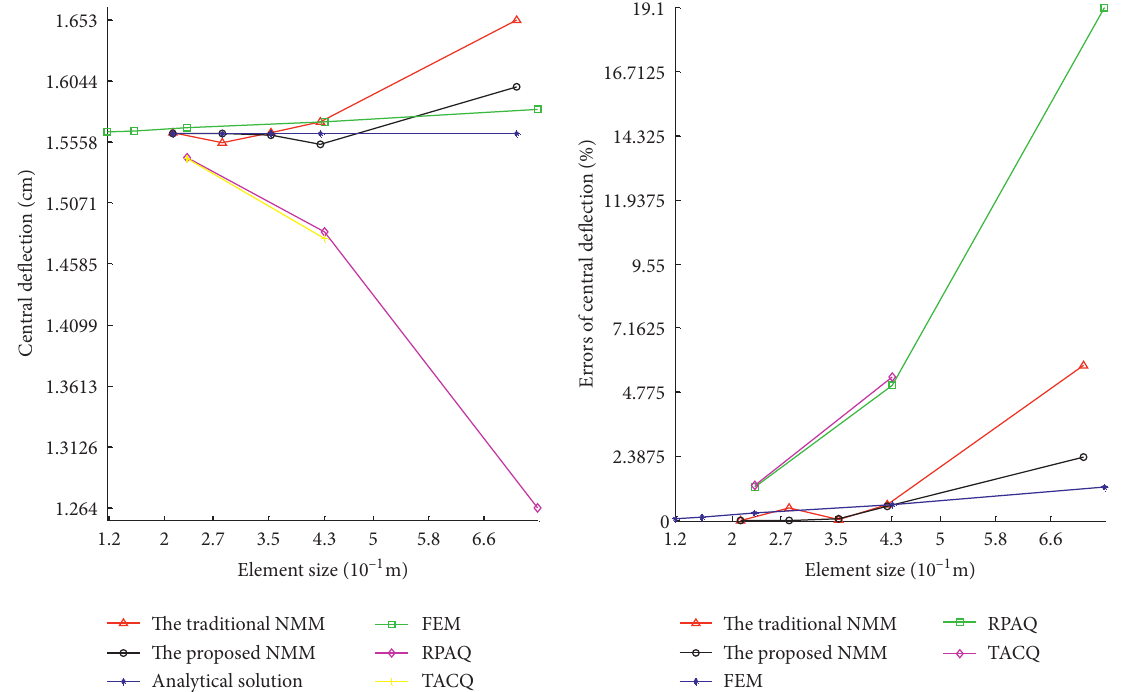
Figure 12: Central deflections (left) and error comparisons (right) of a clamped circular plate under distributed load calculated with different